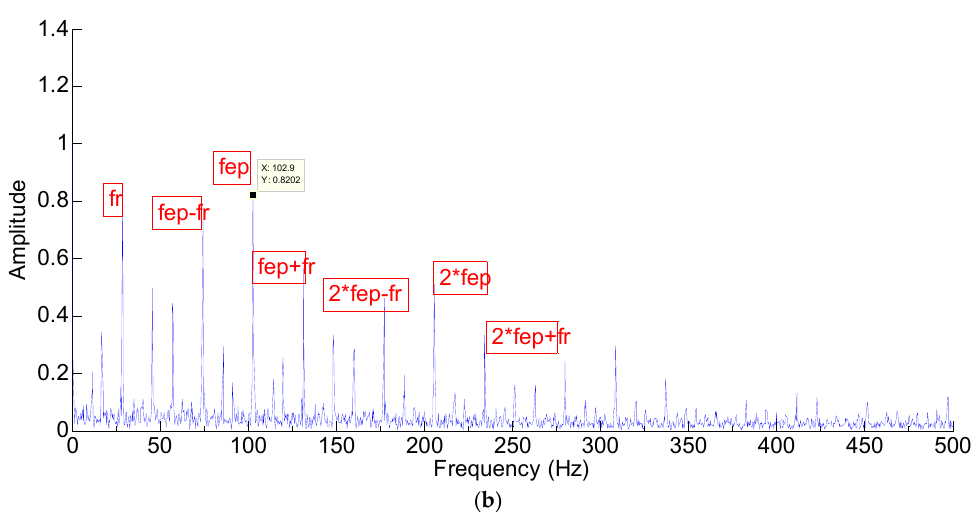
Figure 7. The decomposition results of vibration with improved EEMD and the spectrum of the demodulated signal. ( a ) The decomposition results of vibration with improved EEMD; ( b ) the spectrum of the demodulated signal.